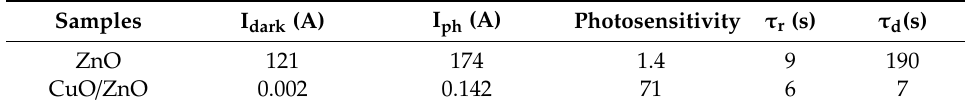
Figure 7. ( a ) The structure of CuO / ZnO heterojunction UV photodetectors. The voltages across the resistance is recorded to calculate the change of the photocurrents across the devices. The I-V characteristics ( b ) pure ZnO NRs and ( d ) the CuO / ZnO heterojunction in dark and under 365 nm light, the inset is the semi-log plot of the V-I curves. The single cycle in the I-t curves of ( c ) pure ZnO NRs and ( e ) the flower-like CuO / ZnO heterojunction NRs under UV illumination. ( f ) The photosensitivity of the CuO / ZnO heterojunction NRs devices prepared from Cu(NO 3 ) 2 solution with di ff erent Cu 2 + ion concentrations. The UV irradiation time and the annealing temperature were fixed at 20 min and 300 ◦ C, respectively. Table 1. The device performance of pure ZnO and CuO / ZnO UV photodetectors.